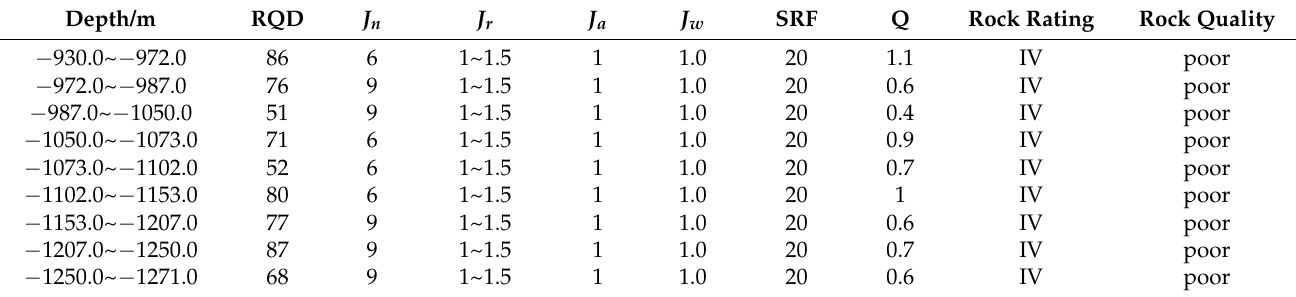
Table 4. The evaluation results of Barton rock mass quality (Q)